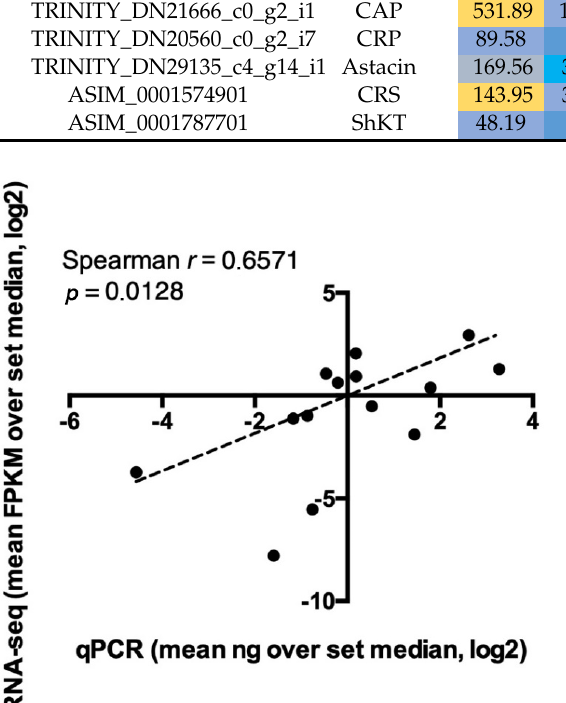
Figure 3. qPCR validation. Correlation between transcriptional abundance of 7 genes in both pharynx and whole larvae tissues revealed by qPCR and RNA-seq. Level of abundance is defined as the ratio between each sample value over the group median in both qPCR and RNA-seq approaches. To correlate datasets from the two techniques, statistical evaluation throughout Spearman test was performed and results are reported in the figure inset.